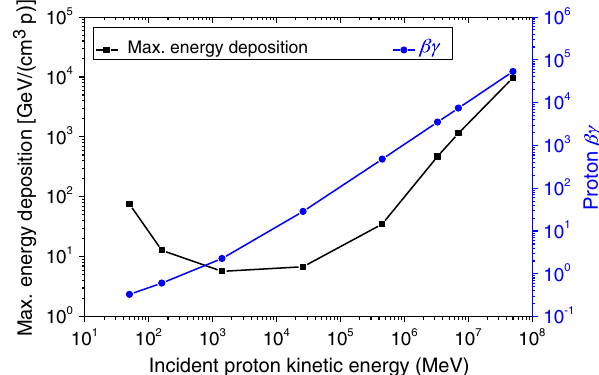
FIG. 6. Maximum energy deposition in copper as a function of the incident proton kinetic energy. The corresponding values of βγ are plotted as well. The beam size is constant (0.2 mm) for the energies from 50 MeV to 50